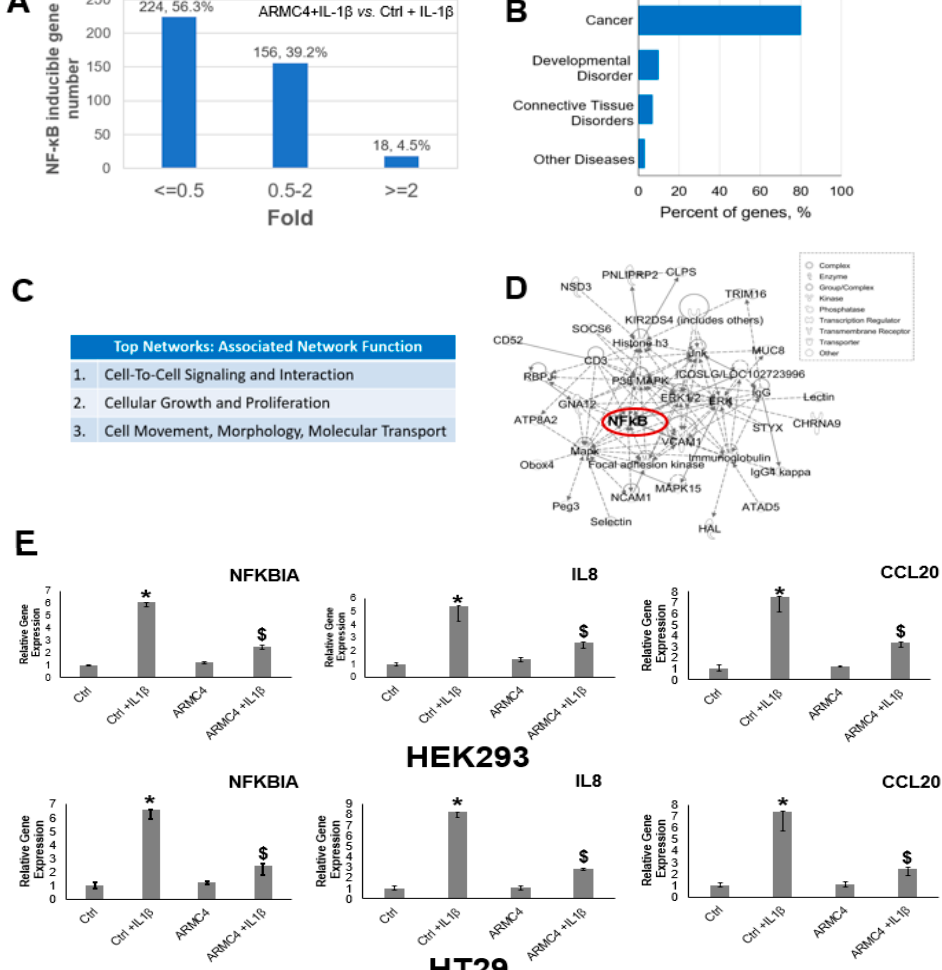
Figure 4. ARMC4 expression decreased NF- κ B target gene expression. ( A ) An RNA-seq was conducted in the presence or absence of 10 ng/mL of IL-1 β in HEK293 cells. Overexpression of ARMC4 decreased 56.3% (224 genes) of NF- κ B target expression by 2-fold or more (ARMC4 + IL-1 β /Ctrl + IL-1 β ≤ 0.5), while leaving 39.2% (156 genes) unaffected (ARMC4 + IL-1 β /Ctrl + IL-1 β = 0.5–2), and merely 4.5% (18 genes) were increased by 2-fold or more (ARMC4 + IL-1 β /Ctrl + IL-1 β ≥ 2). Cells were treated or untreated with IL-1 β for 4 h before RNA was collected. ( B – D ) Ingenuity pathway analysis (IPA). IPA analysis identified near 80% of ARMC4-downregulated NF- κ B target genes are cancer related ( B ), suggesting ARMC4’s important negative NF- κ B regulation function in cancer. IPA also identified that ARMC4 has several top network cellular functions, including cell-cell signaling, proliferation, and cell morphology ( C ). Furthermore, IPA analysis identified a typical network that was regulated by ARMC4, in which NF- κ B is at the hub of this network ( D ). ( E ) qPCR analysis of typical genes identified, confirming NFKBIA, IL-8, and CCL20 are NF- κ B-inducible genes (+IL-1 β condition) and were significantly downregulated by the overexpression of ARMC4 in both HEK293 (top row) and HT29 cells (bottom row) under IL-1 β treatment. The data represent the means ± SD from three independent experiments. * p < 0.05 Ctrl + IL-1 β vs. Ctrl group; $ p < 0.05 ARMC4 + IL-1 β vs. Ctr + IL-1 β group; n =